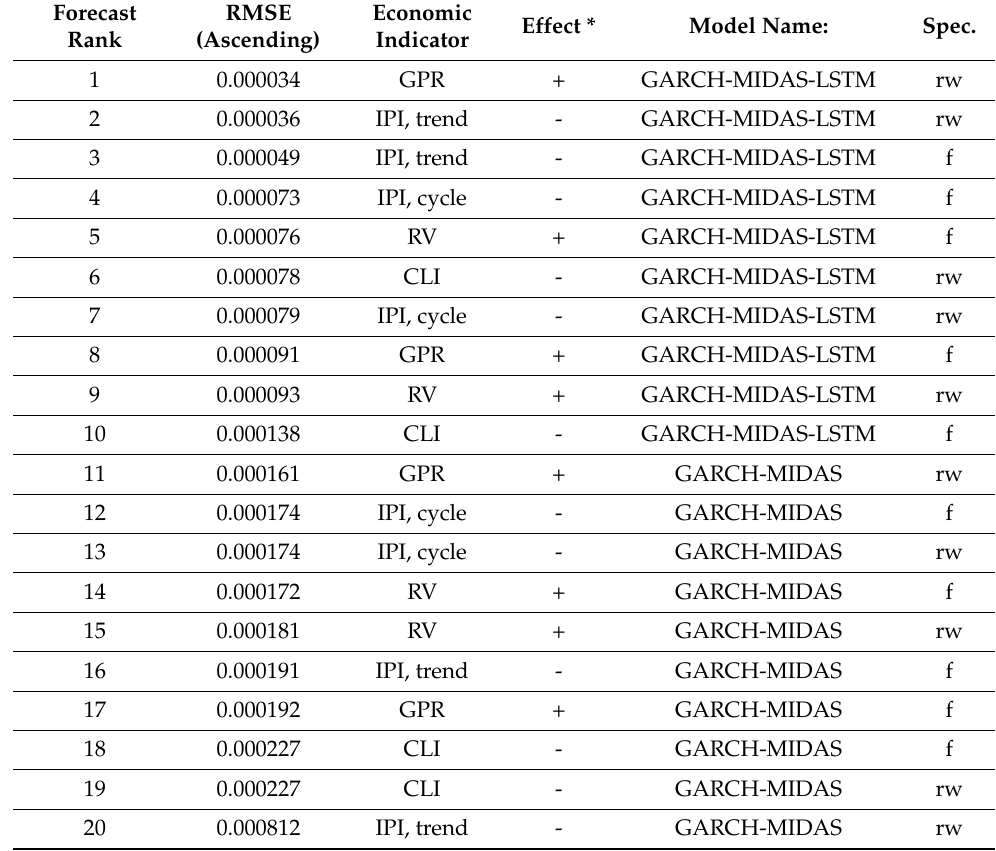
Table 7. Out-of-Sample Forecast Accuracy Comparison and Ranks, 23 Days Ahead.